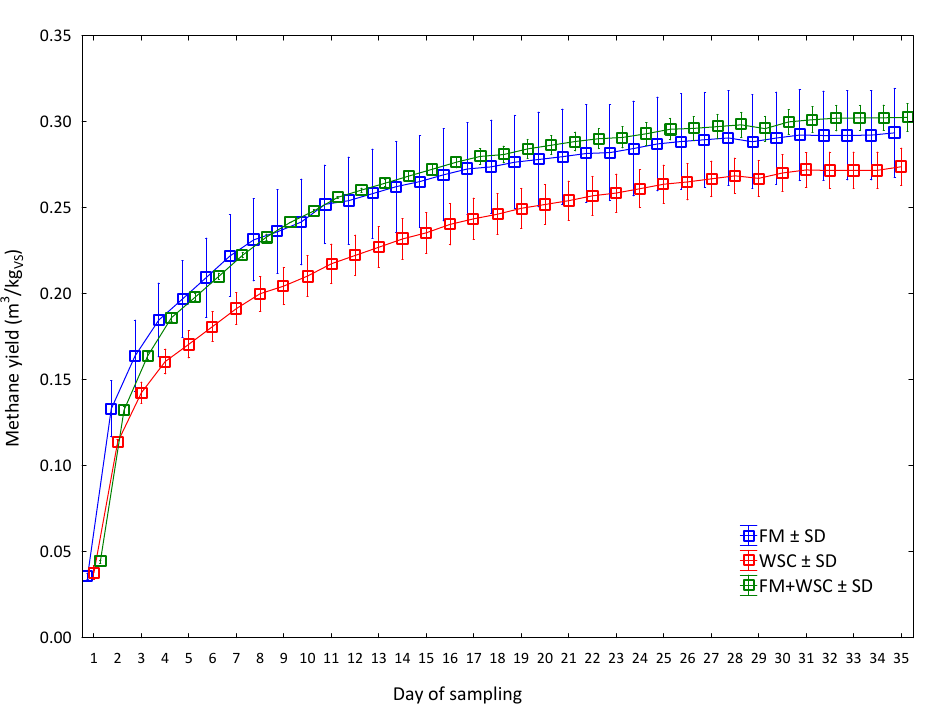
Figure 5. Methane yield during 35 days of the experiment (average values for every day of measurement (n = 3) for one measurement, ± SD). FM—fodder mallow; WSC—white sweet clover.